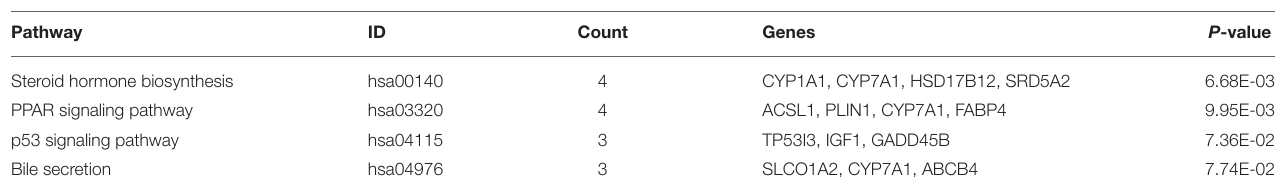
TABLE 3 | KEGG analysis of DEGs associated with NAFLD in the RRA analysis. Pathway